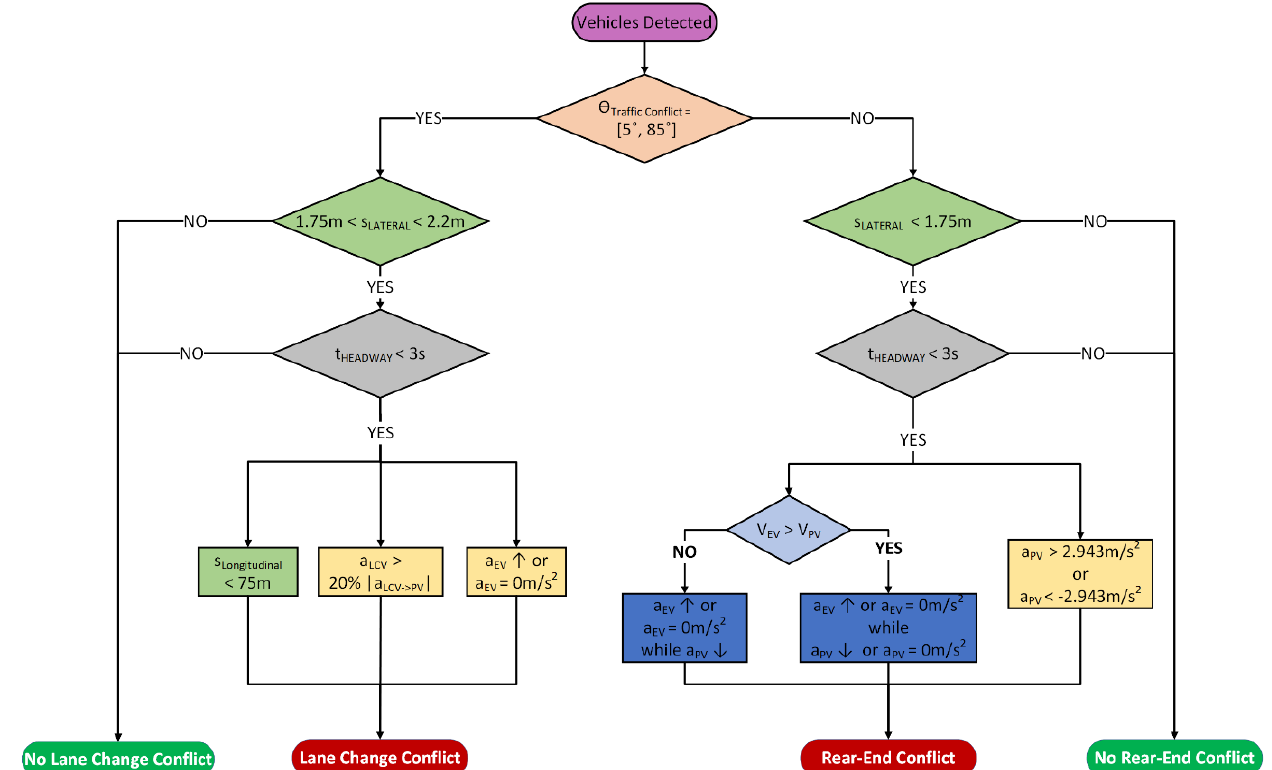
Figure 1. Automatic extraction algorithm for lane change and rear-end conflicts from video where EV, PV, and LCV represent the ego-vehicle, preceding vehicle, and lane change vehicle, respectively, while θ , t, s, V, and a represent angle, time, distance, velocity, and acceleration, respectively. Based on these criteria, the timestamps of each identified traffic conflict were recorded and validated. When the threshold was exceeded, the timestamp was highlighted as a traffic conflict by the system.